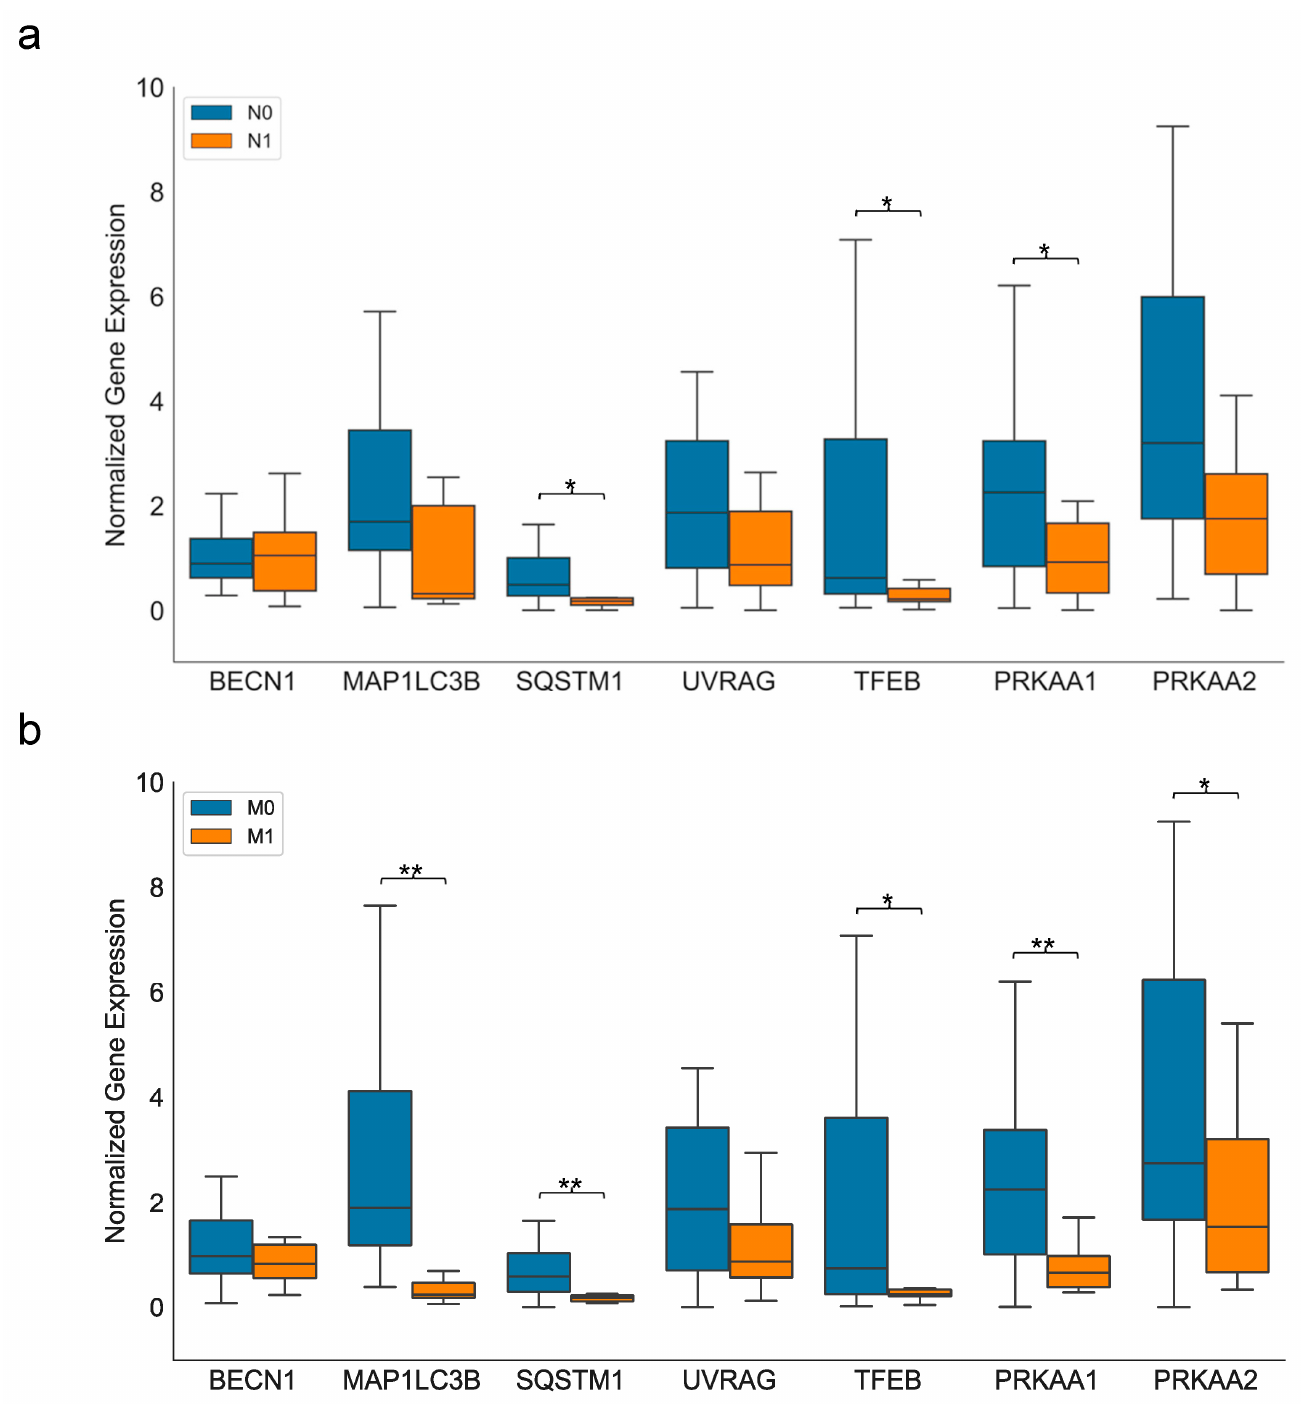
Figure 2. Box and whisker plot showing the expression of autophagic gene transcripts in sporadic pNEN. ( a ) N0 vs. N1; ( b ) M0 vs. M1; * p < 0.05 and ** p < 0.001 were considered significant in Mann–Whitney U test. N0 = no lymph node metastasis; N1 = lymph node metastasis; M0 = no distant metastasis; M1 = distant metastasis.